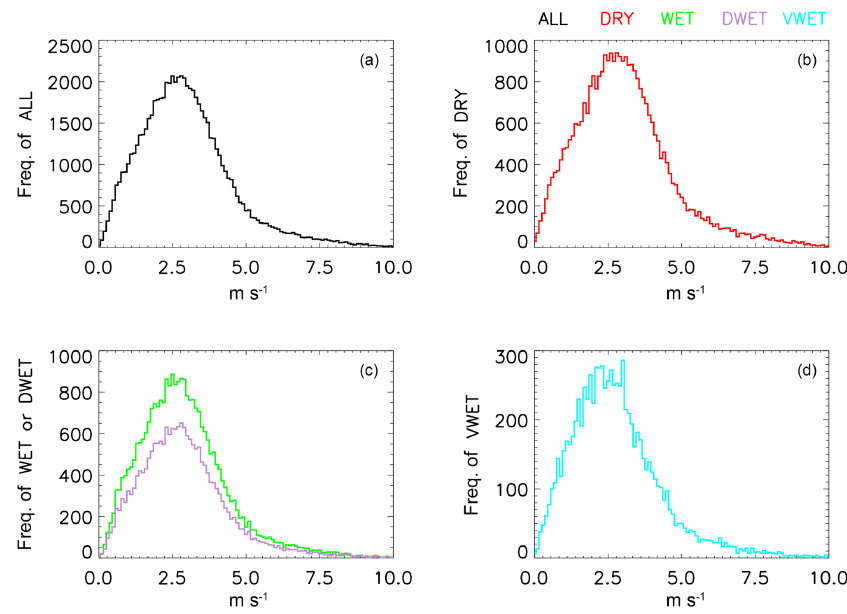
Figure 8. Histograms of half-hourly mean wind speed for 2013–2016. The colours are the same as in Figs. 5 and 6.